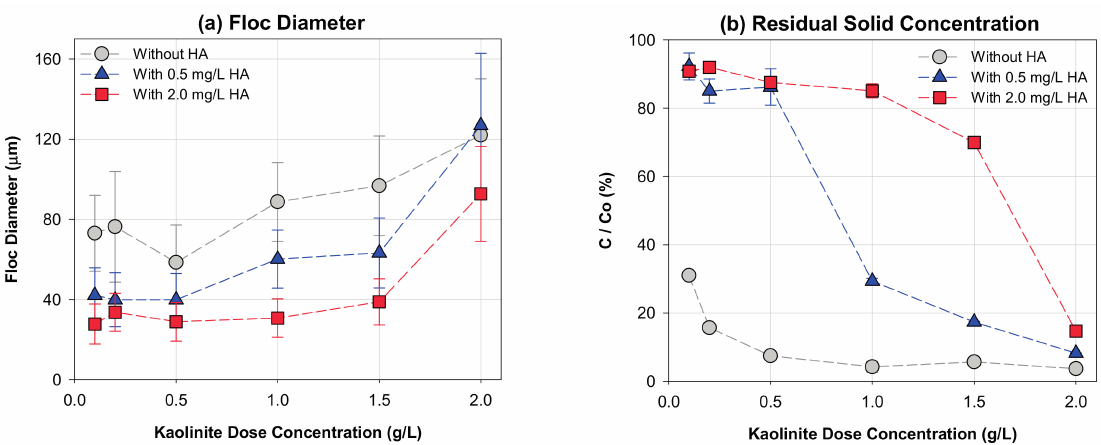
Figure 8. Results from the supplementary flocculation potential tests with artificial water containing 10 mg/L of refined extracellular polymeric substances (EPS) and 0, 0.5, and 2.0 mg/L of humic substances (HS). ( a , b ) show floc diameters (D Floc ) and the normalized ratios of the residual solid concentration (C/Co), respectively, at increasing kaolinite